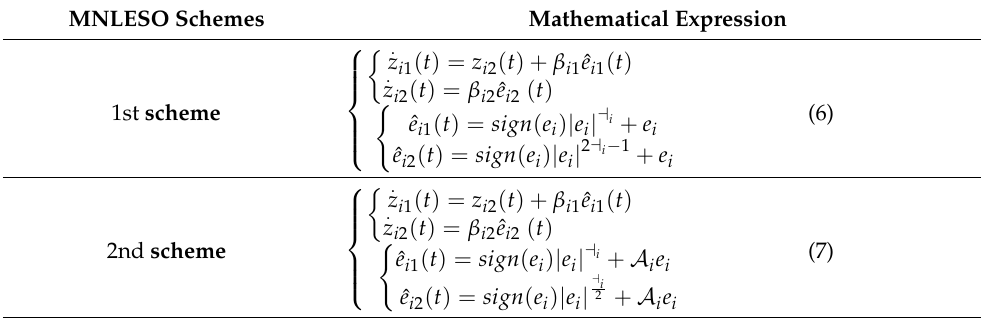
Table 2. MNLESO mathematical expressions. MNLESO Schemes Mathematical